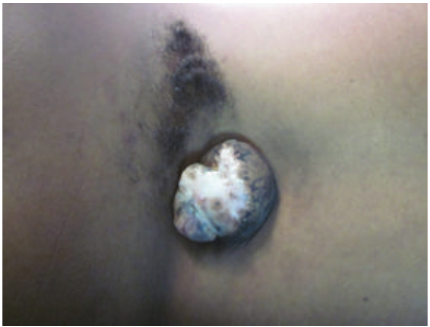
Figure 1: Lower lumber cicatrized myelomeningocele with hyper-